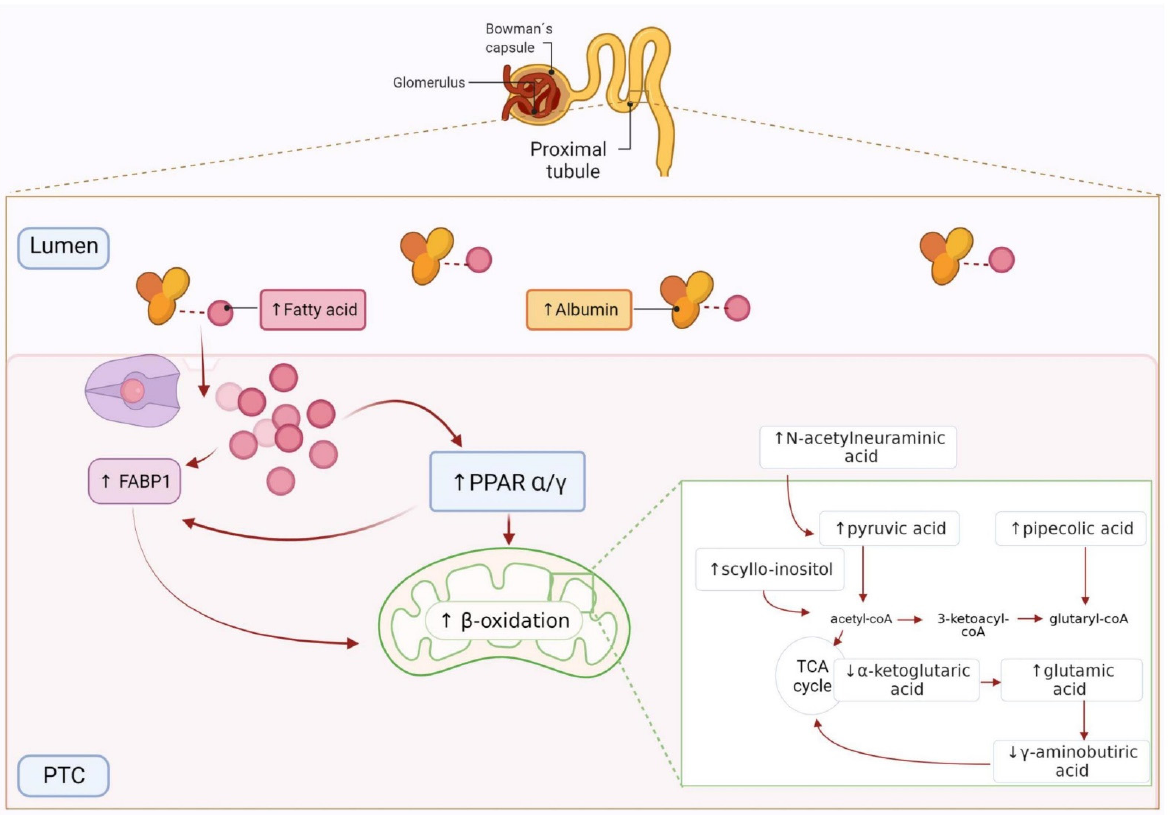
Figure 4. Graphic representation of fatty acids (FAs) oxidation in the proximal tubular cells (PTCs) and related metabolites. Albumin-bound FAs are taken up by FABP1 into the PTCs, transported to mitochondria and metabolized by β -oxidation. Arrows represent the metabolites abundance trend between control and HN subjects. Created with Biorender.com.